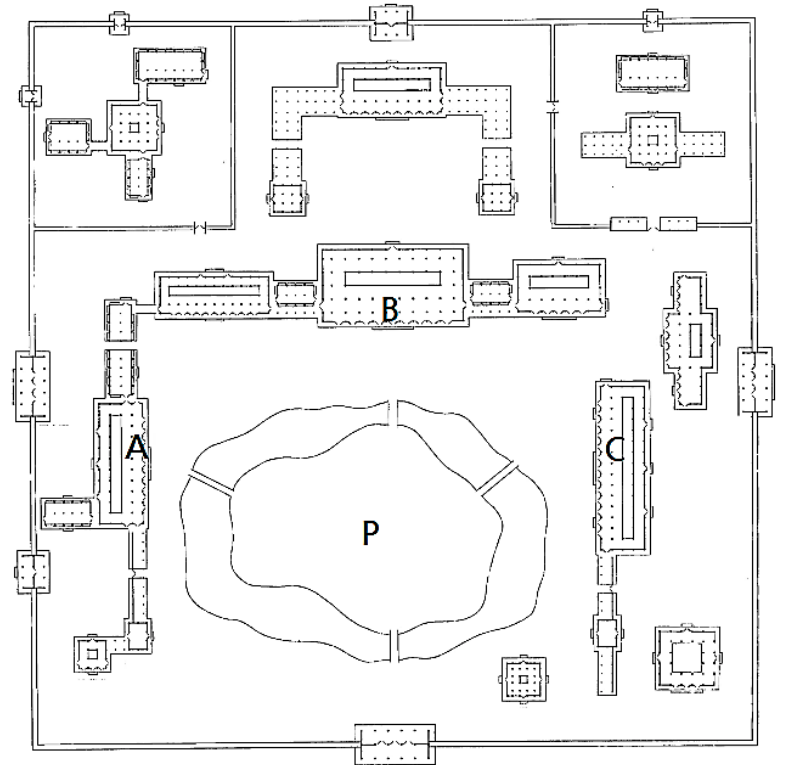
Figure 14. The first construction of the Monastery Hojoji. P: A platform for rituals on an island, a lotus pond, C: Yakushi Hall, A: Amitabha Hall, B: Main Hall.